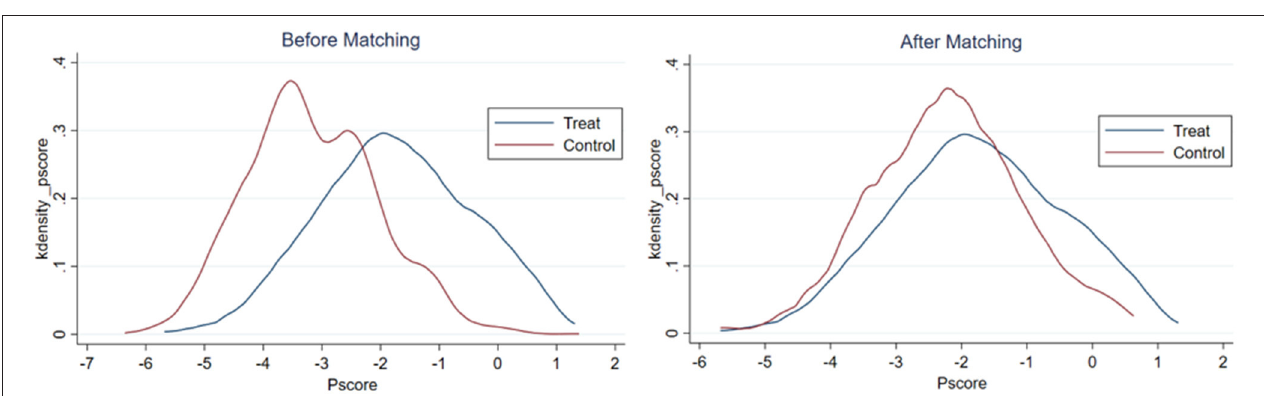
FIGURE 3 | Results of balance hypothesis test: self-employed.